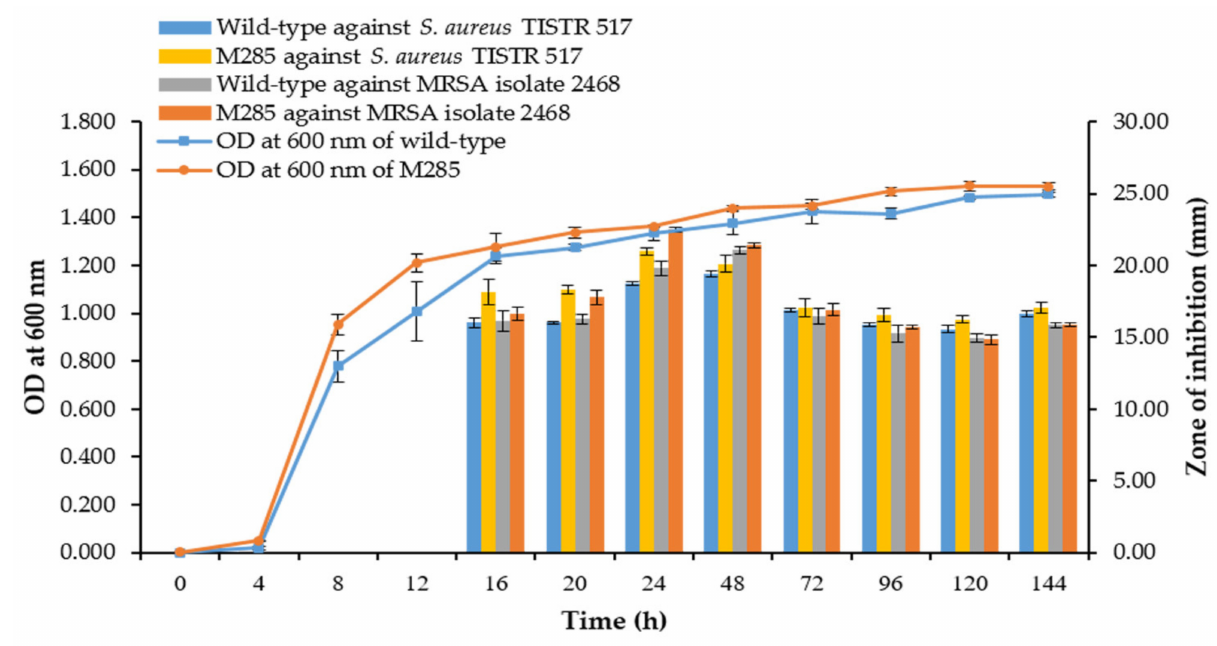
Figure 7. Growth curve and production kinetics of antibacterial substances of the wild-type and M285 strains.